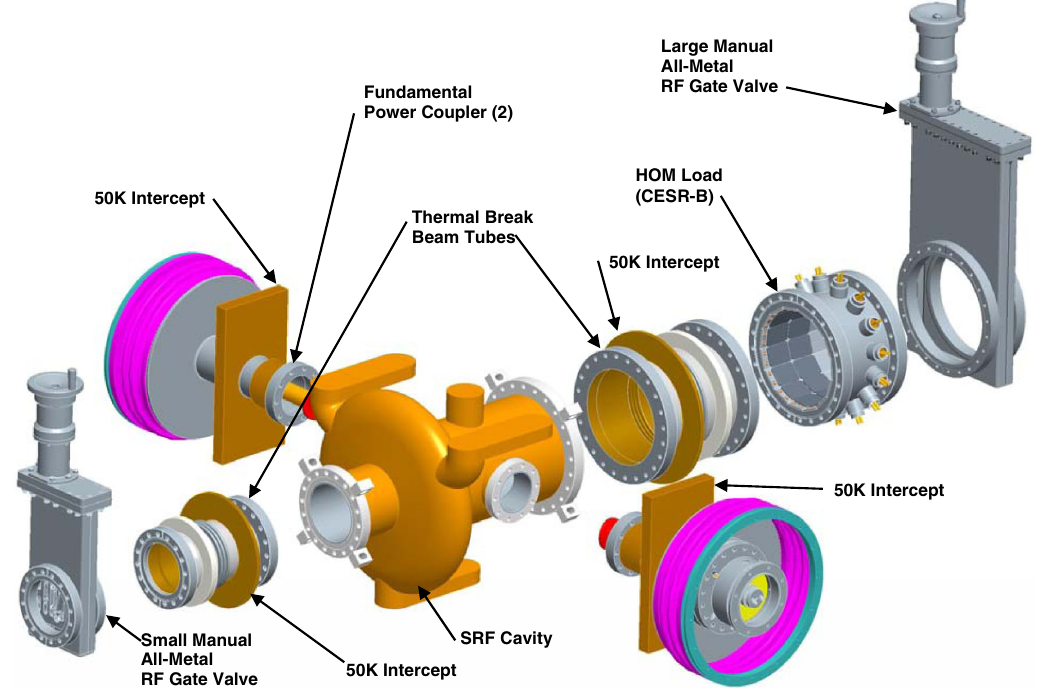
FIG. 18. 3D model of the components comprising the hermetic string to be assembled in the clean room.